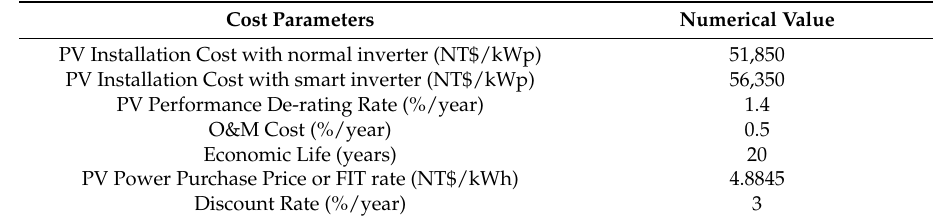
Table 1. Cost parameters used for economic evaluation; O&M: operating and maintenance; FIT: feed-in tariff.